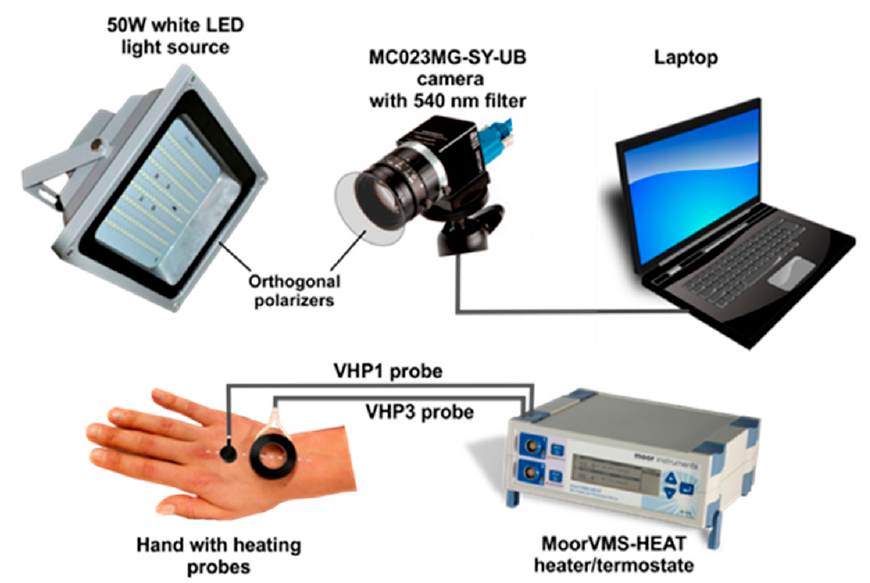
Figure 1. Remote photoplethysmography setup and used equipment; Palm dorsal aspect middle line is denoted by white dotted line.